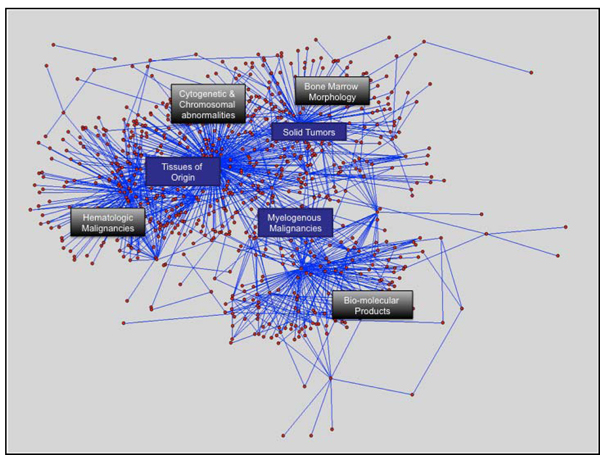
Energy-minimized graph visualization of semantically anchored union of network constructs generated in Phases 1a-1c, with significant groups of nodes annotated to indicated broad concept classes.